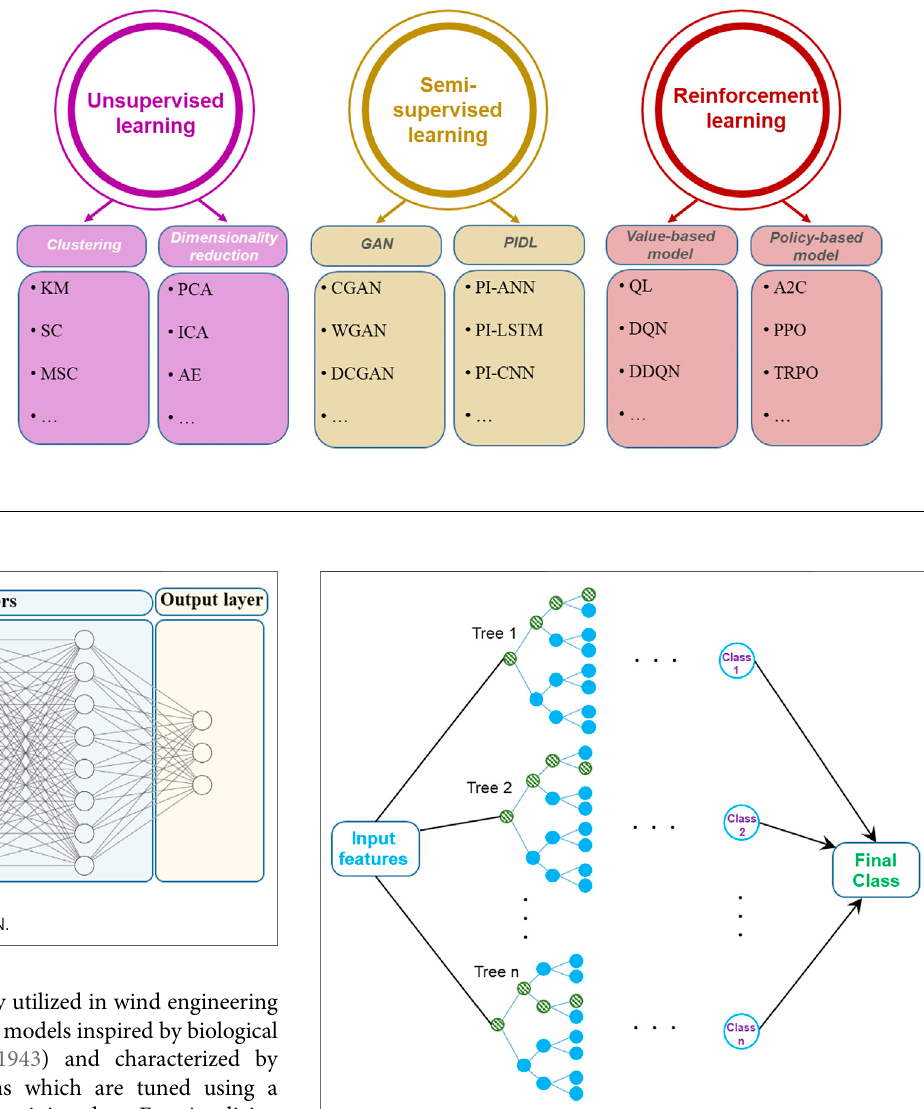
FIGURE 3 | Architecture of a typical random forest classi fi